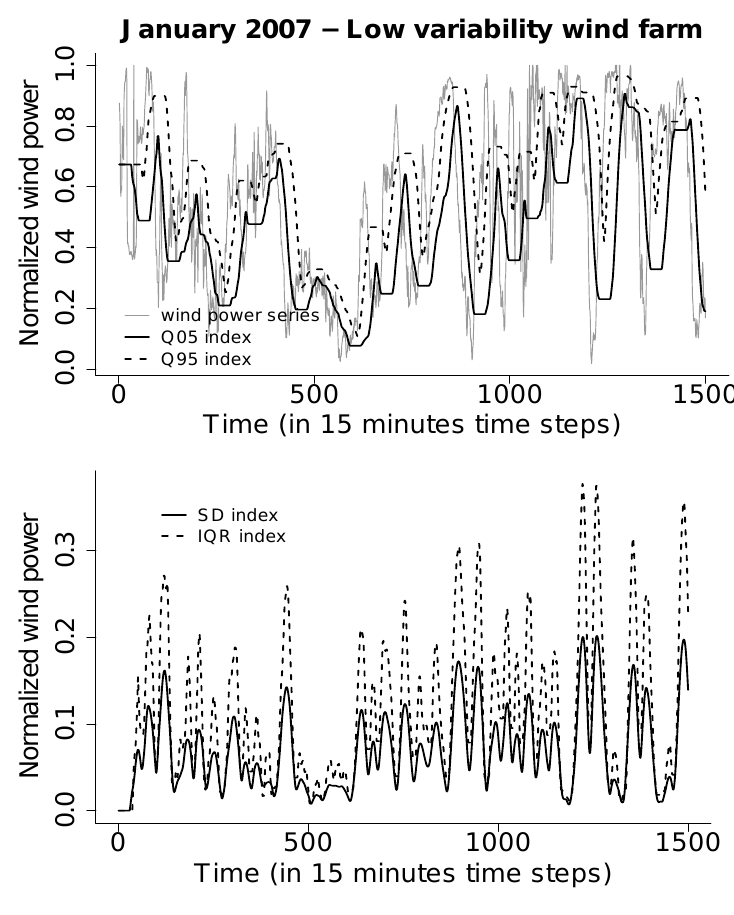
Figure 2. Wind power time series plot of the low variability farm, together with the four variability indices (Q05, Q95 on upper plot, and SD, IQR on lower plot). The parameters are chosen to be the same for all indices to facilitate comparison ( m = 30 and n = 30